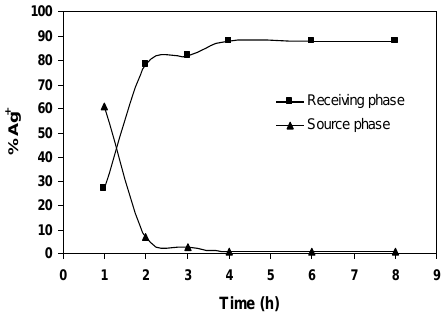
Figure 7. Effect of time on Ag + cation transport. Experimental conditions: source phase, 10 ml of 3.0×10 -4 M Ag + cation and 3.0×10 -3 M picric acid at pH 4; liquid membrane phase, 50 ml of 1.0×10 -3 M carrier in DCM; receiving phase, 5 ml of 1.0×10 -3 M S